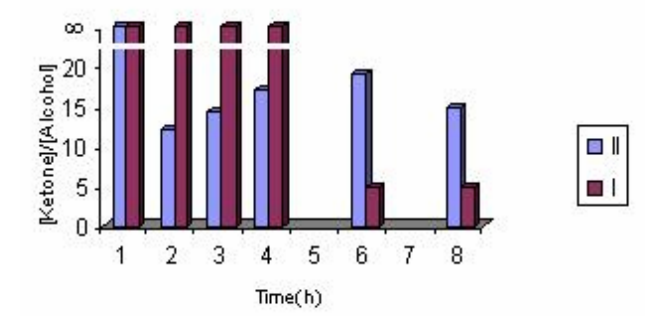
Figure 8. Variation of the [acetophenone]/[1- phenylethanol] ratio vs. time for experiments 2 and 9.